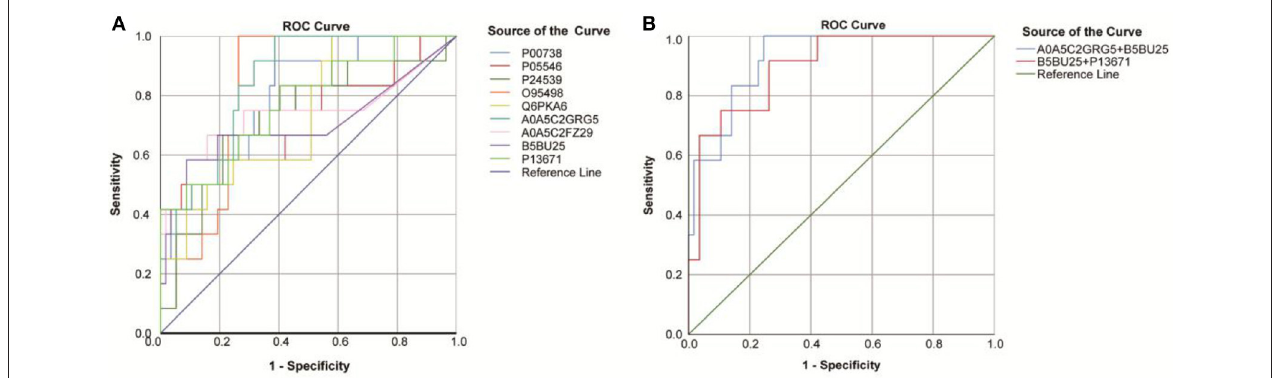
FIGURE 8 | Receiver operating characteristic (ROC) curves obtained from each DEP and two top combining proteins, for the classification status of the DVD group from other groups. (A) ROC curves obtained from nine DEPs identified by the proteomic analysis. (B) ROC curves obtained from the two top combining proteins [A0A5C2GRG5 (no name) + U2AF2 and U2AF2 +